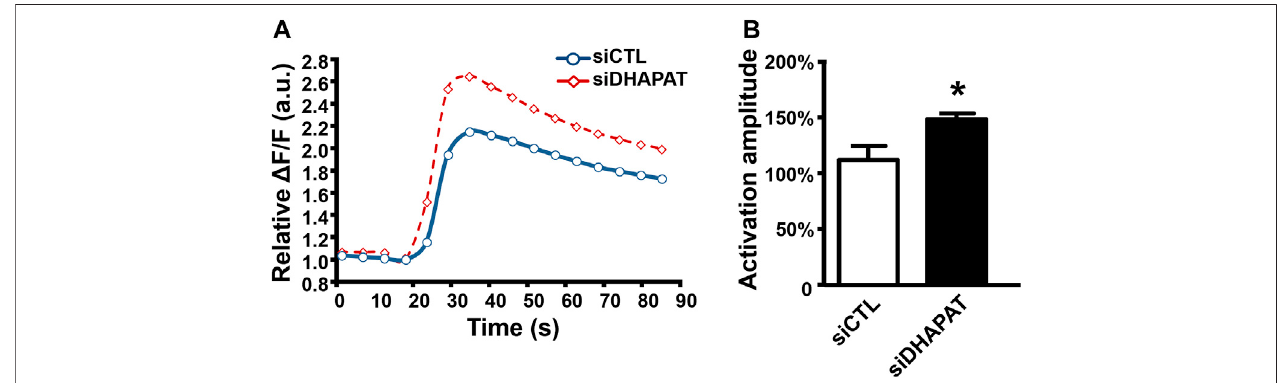
FIGURE 6 | Plasmalogen depletion enhances the calcium response of ATP-stimulated Müller cells. (A) Mean kinetic curves responses of control (siCTL) and plasmalogen-depleted (siDHAPAT) primary Müller cells stimulated with ATP. (B) Activation amplitude of ATP-stimulated Müller cells show that plasmalogen-depleted Müller cells display a signi fi cantly increased calcium response. n = 4. Mann & Whitney test. * p < 0.05. Data shown as mean ±